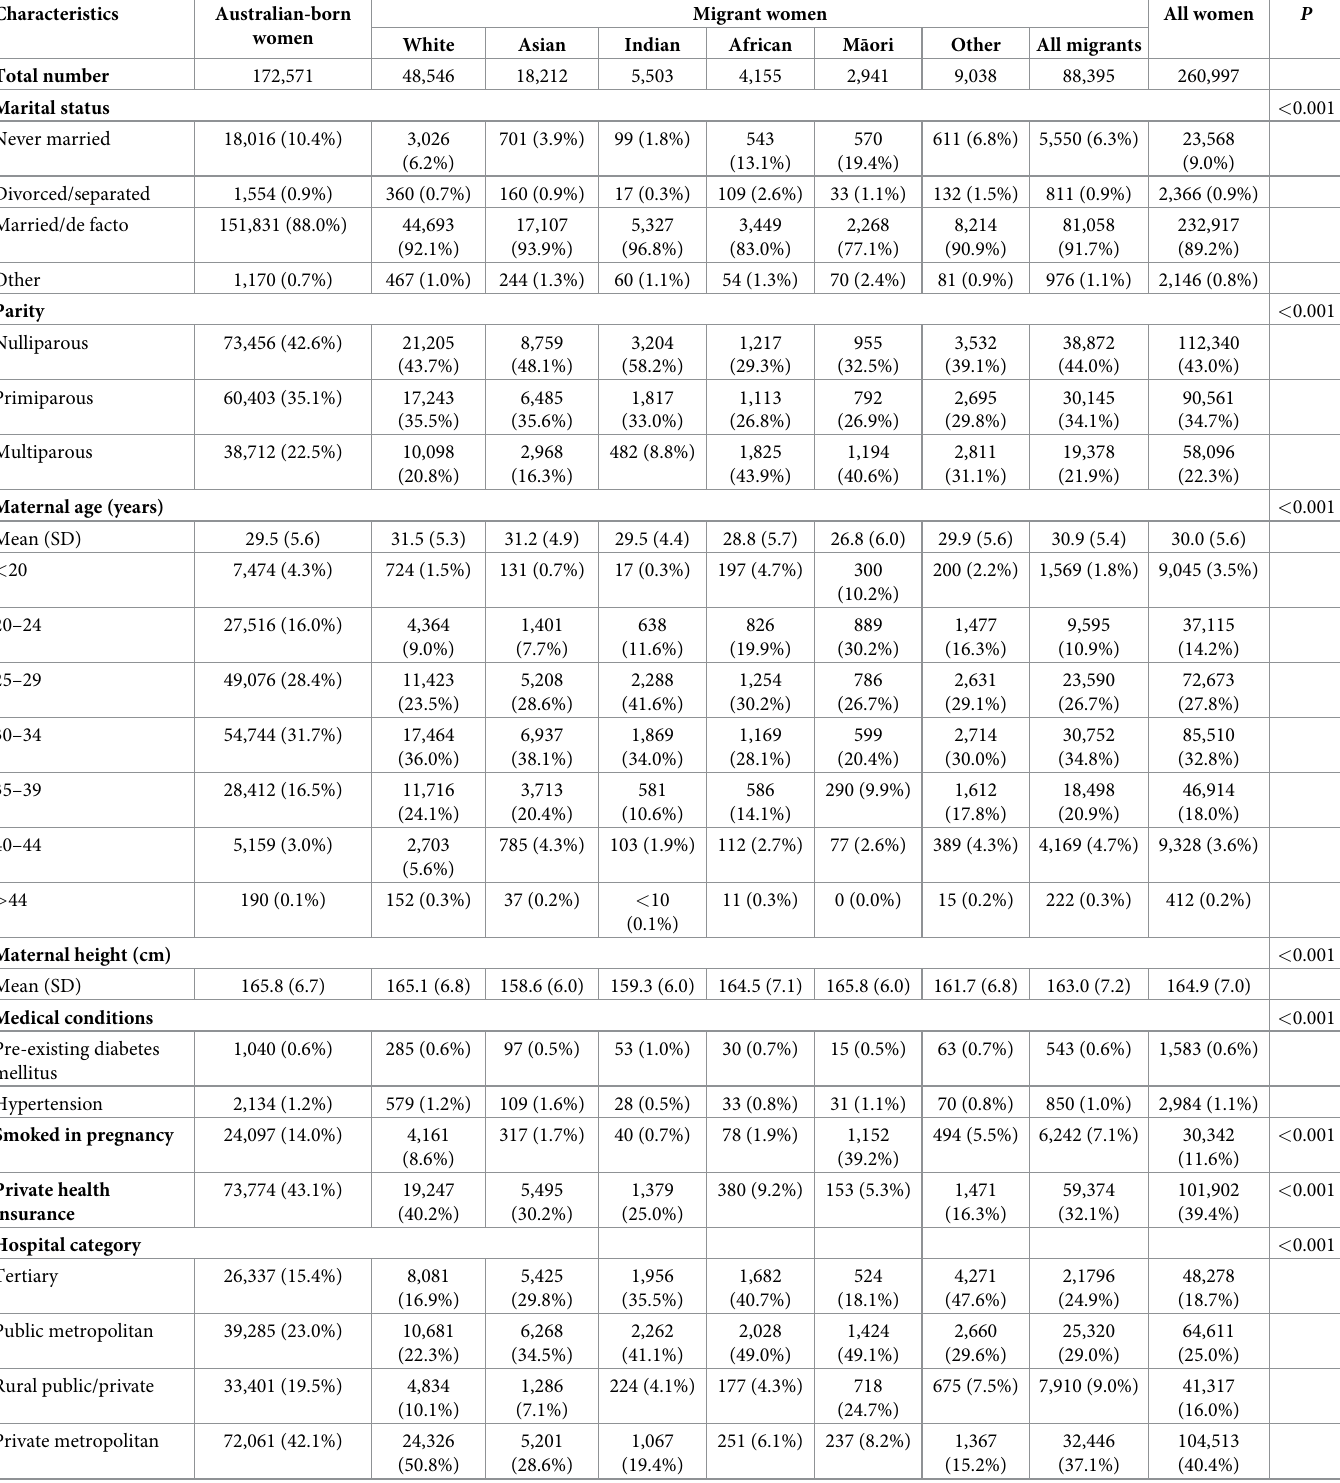
Table 1. Demographic characteristics of the study population.